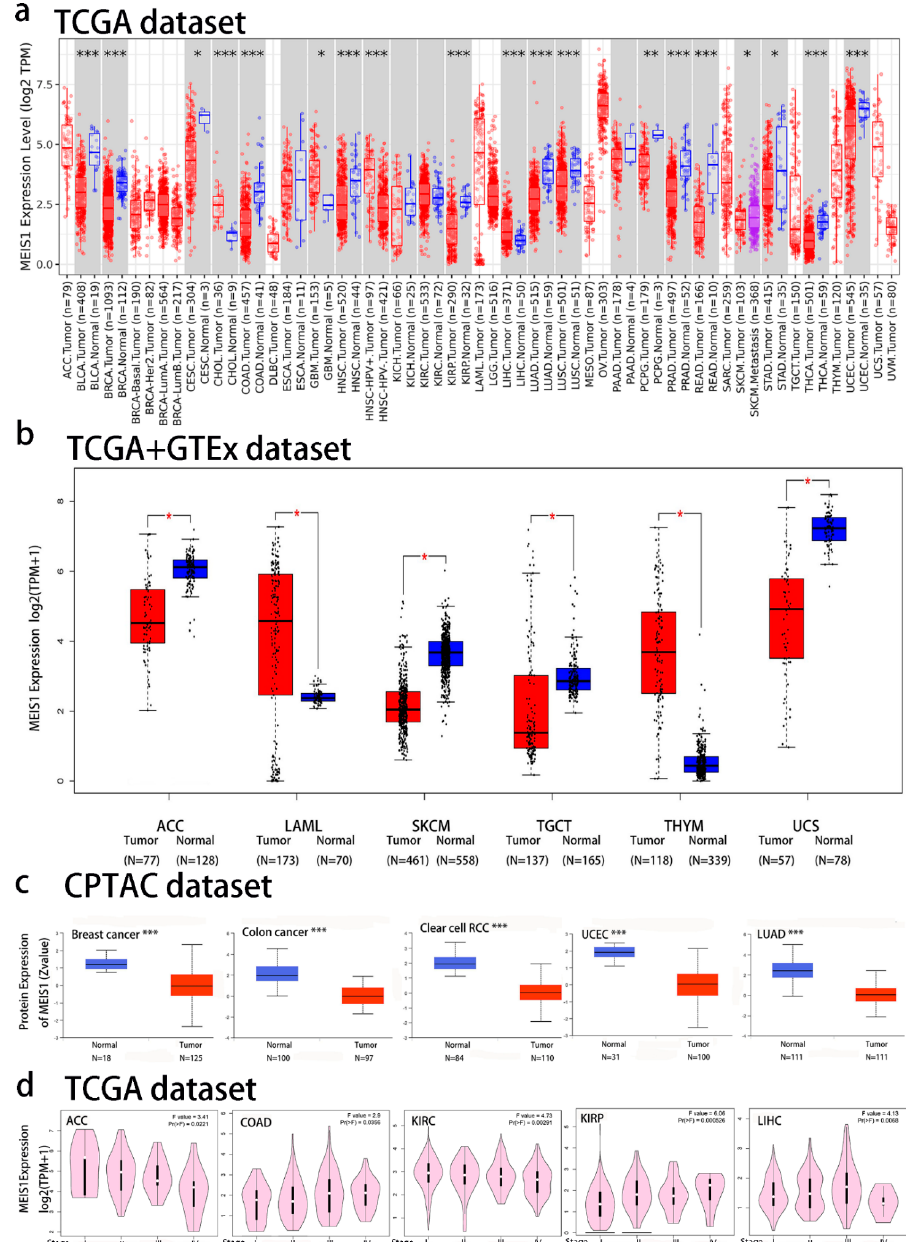
Figure 1. MEIS1gene and protein expression in 33 tumors and pathological stages of tumors. ( a ) MEIS1 gene expression level in 33 tumor tissues and normal tissues, even specific subtypes of tumors through TIMER2 (Blue represents normal tissues, red represents tumor tissues and purple represents metastatic tumors). *** p < 0.001; ** p < 0.01; * p < 0.05. ( b ) MEIS1 gene expression in tumors without normal tissues in TCGA, including ACC, LAML, SKCM, TGCT, THYM and UCS. * p < 0.05. ( c ) Total protein expression level of MEIS1 in tumor tissues and normal tissues of Breast cancer, Colon cancer, ccRCC, UCEC and LUAD. *** p < 0.001. ( d ) MEIS1 expression level in different pathological stages of ACC, COAD, KIRC, KIRP and